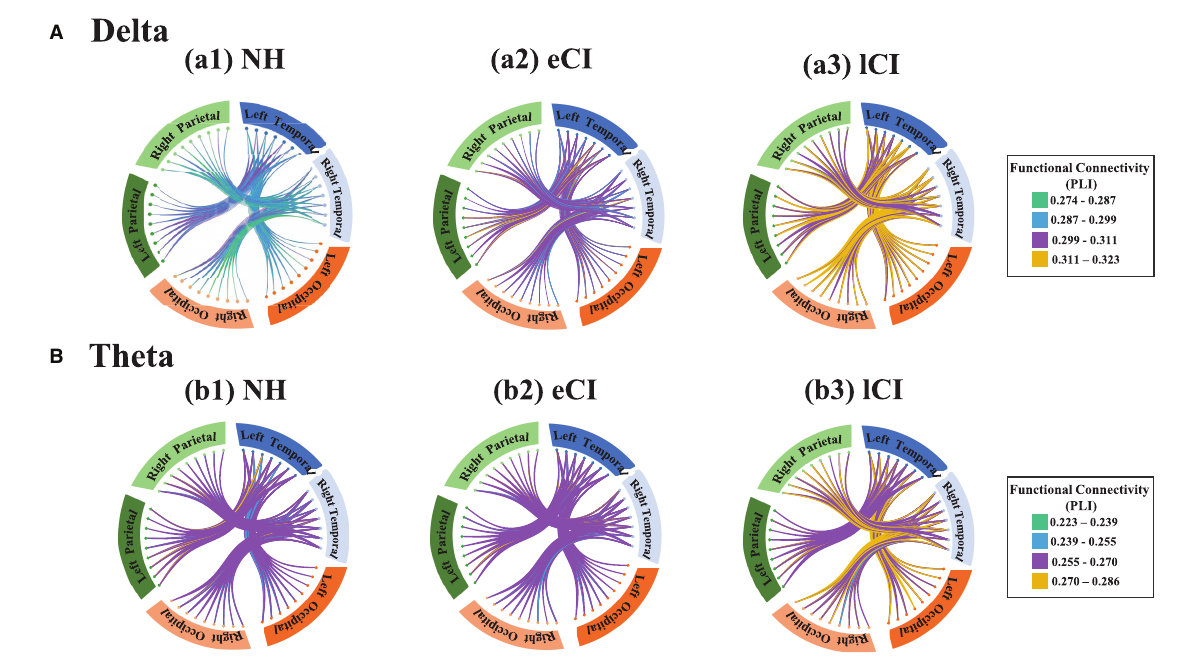
FIGURE6 Functional connectivity between the temporal region and the occipital region and between the temporal region and parietal region in the delta band (A) and the theta band (B) . Small dots represent electrodes; dots of the same color belong to the same region, whereas those of different colors belong to different regions. The brain regions corresponding to each group of electrodes are shown around the circles: blue boxes represent the left temporal region, light blue boxes represent the right temporal region, orange boxes represent the left occipital regions, light orange boxes represent the right occipital region, dark green boxes represent the left parietal region, and light green boxes represent the right parietal region. The connecting lines between electrodes reflect phase lag index (PLI) values, i.e., the strength of the functional connectivity between regions, with green lines indicating the weakest connections and yellow ones indicating the strongest connections. In the delta band, the lCI group (a3) showed higher connection strength (more yellow connections) than the NH group (a1) or the eCI group (a2) between the temporal and occipital regions, both left and right. However, the connection strengths in the temporal and parietal regions were similar among the NH, eCI, and lCI groups in both the delta band and the theta